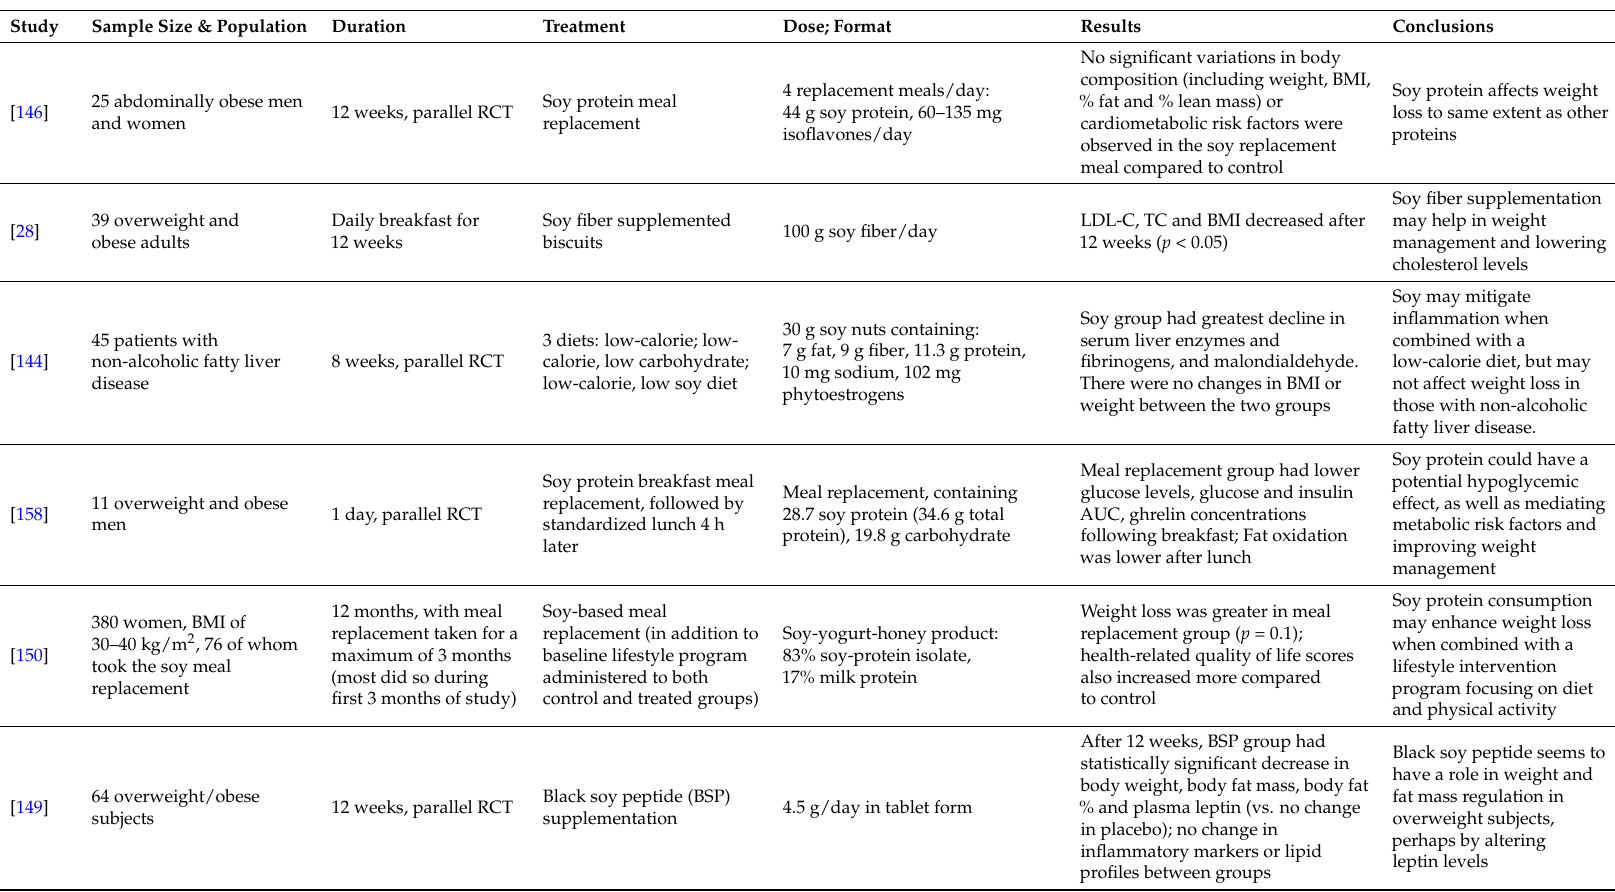
Table 3. Summary findings from randomized control trials based on the impact of soy on obesity and